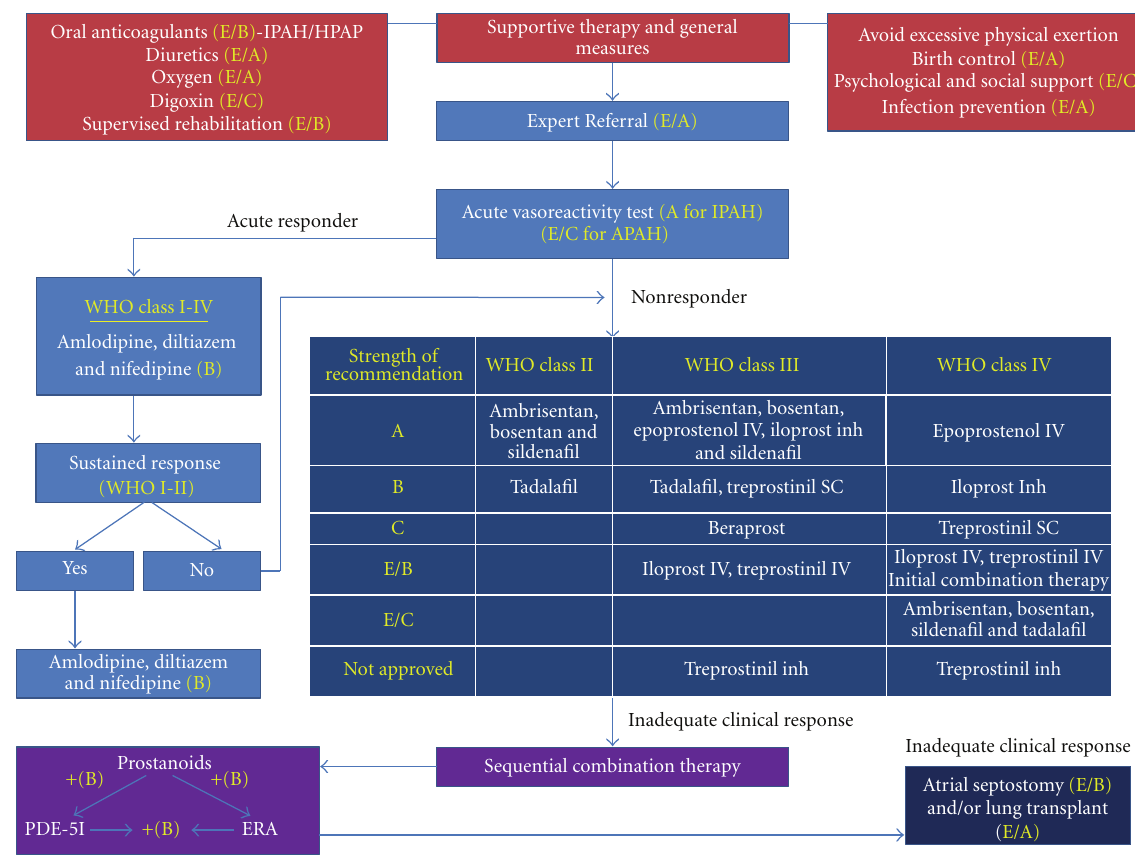
Figure 3: Adapted from